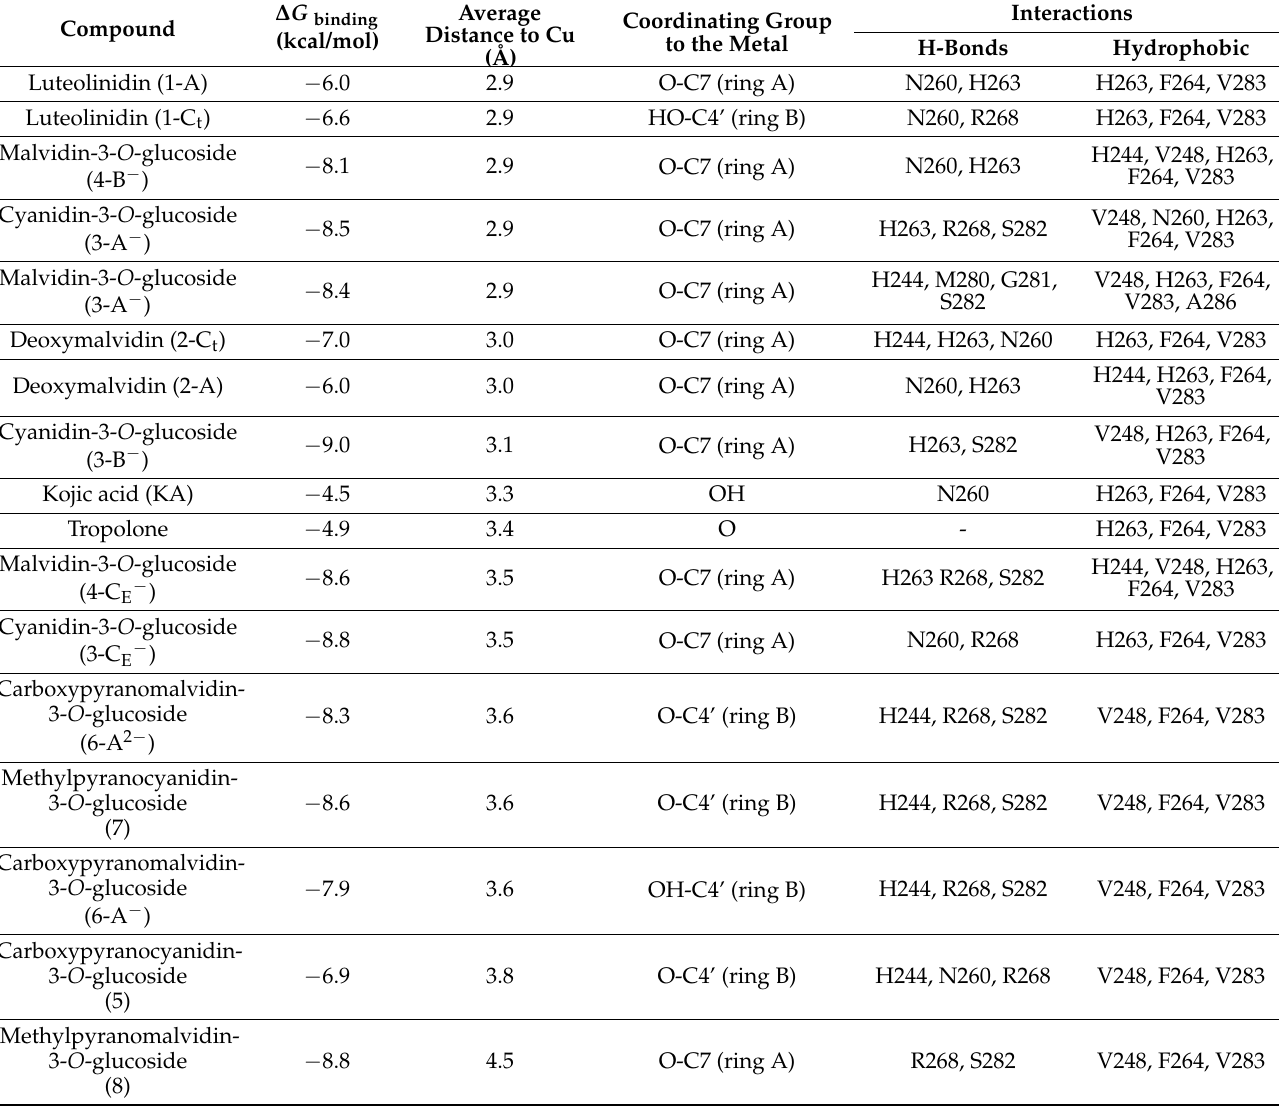
Table 3. Affinity energy values for the best poses of all compounds into the active site of mTYR, the average distance for the closest Cu-coordinating group, and the most relevant interactions between tyrosinase and all the potential inhibitors. Compounds ranked by their distance to the metal center.